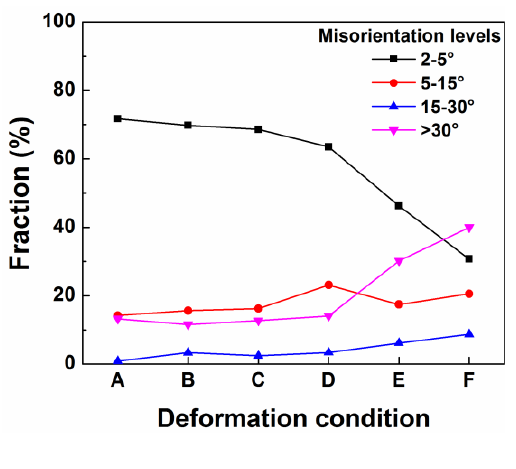
deformation conditions: A, 300 °C, 10 s −1 ; B, 300°C, 1 s −1 ; C, 350 °C, 0.1 s −1 ; D, 400 °C, 0.01 s −1 ; E, 450 °C, 0.01 s −1 ; and F, 450 °C, 0.001 s −1